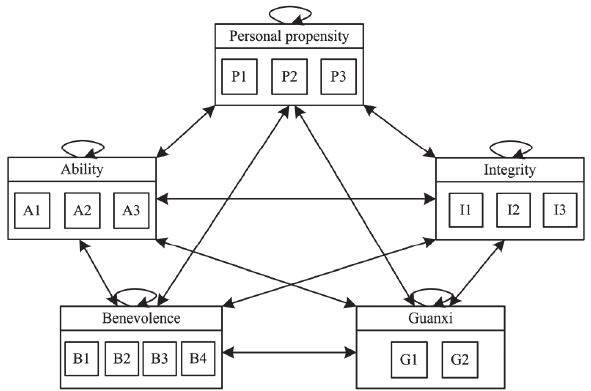
Figure 1. Interdependence of the elements in the ANP network